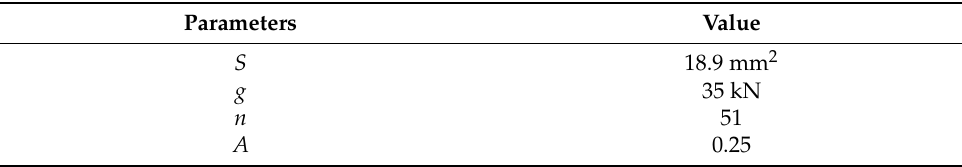
Table 3. The parameters of the submarine cable.